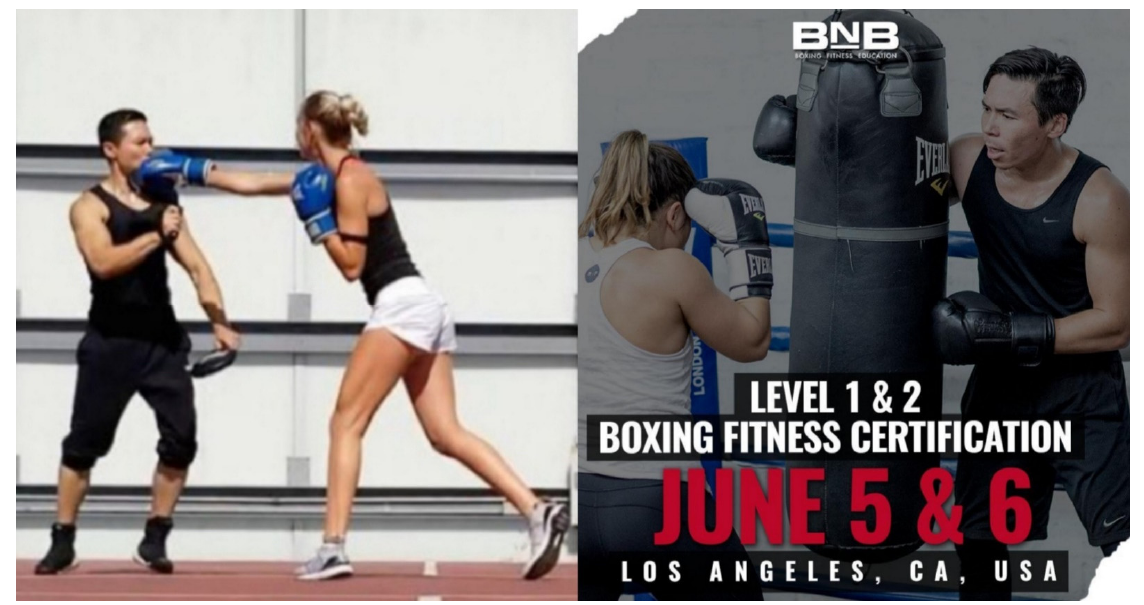
Figure 5. Muay Thai can contribute to meaning or purpose in life. An important part of martial arts training is serving as a supportive training partner for others. The photo on the right is from a social media ad posted by Box N Burn in Santa Monica, California.